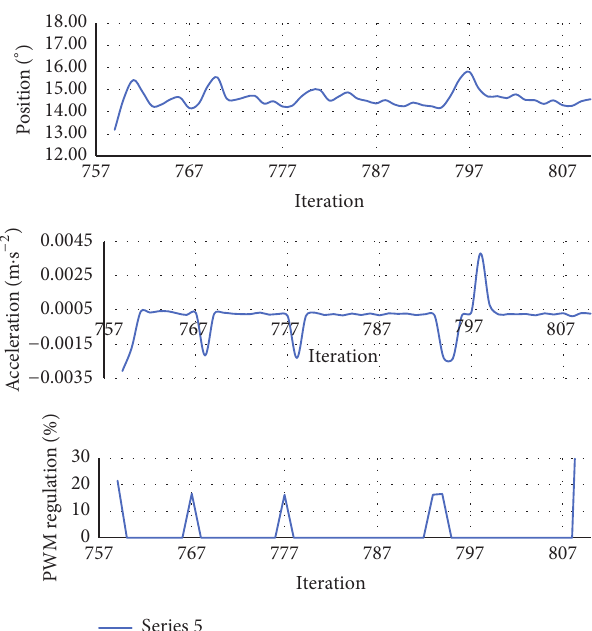
Figure 12: A graphical representation of the experimental measure- ment number 2; positioning accuracy = 1 ∘